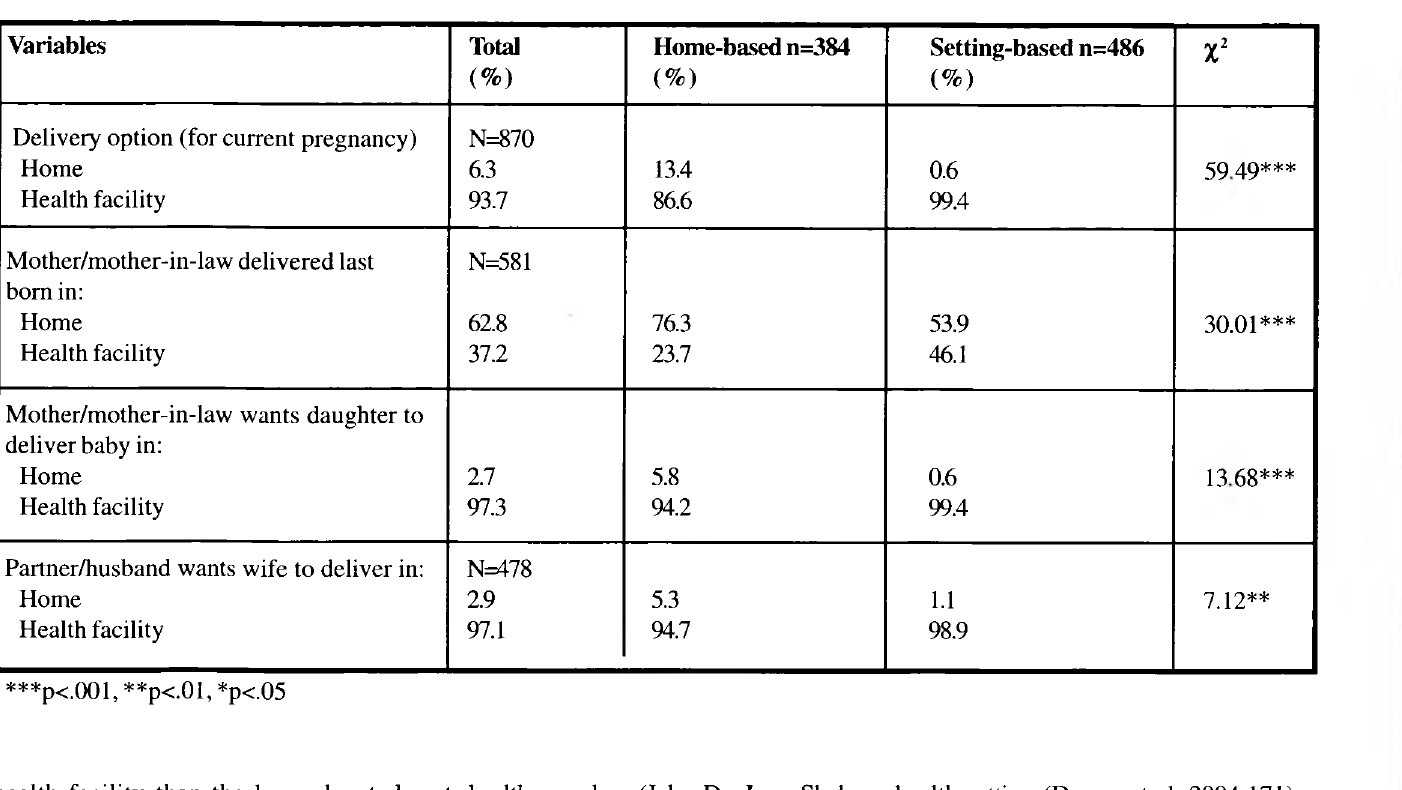
Table 4: Delivery options for the current pregnancy